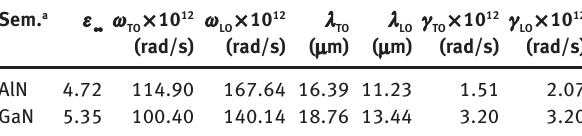
Table 3: Anisotropic PhP responses of AlN and GaN: the ionic permittivity parameters for electric field parallel to the c -axis (optical axis) are shown here; the corresponding ones for electric field perpendicular to the c -axis were given in Table